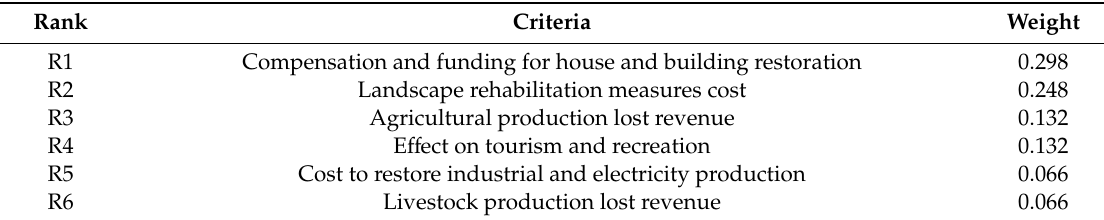
Table A14. Pair-wise comparison reciprocal matrix for economic losses, compensation, and revenue losses fire e ff ects category. RCI: random consistency index; CI: consistency index; CR: consistency ratio; λ max : principal